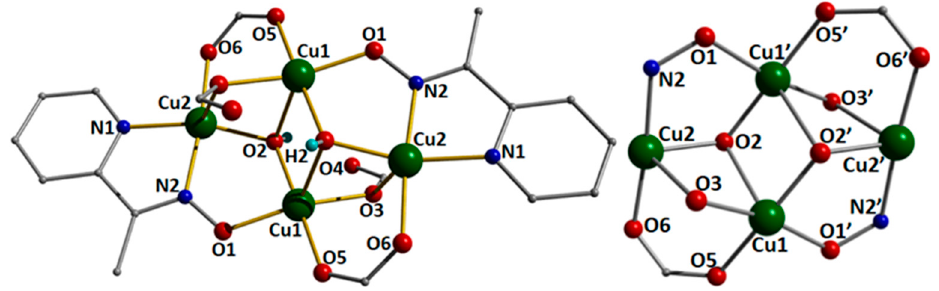
Figure 7. Representations of the repeating unit ( left ) in 9 and its [Cu 4 ( µ 3 -OH) 2 ] 6 + butterfly” shaped core ( right ). Color code: Cu II , green; N, blue; O, red; C, grey. The hydrogen atoms are omitted for clarity, except from the hydrogens of the hydroxyl groups, which are cyan.